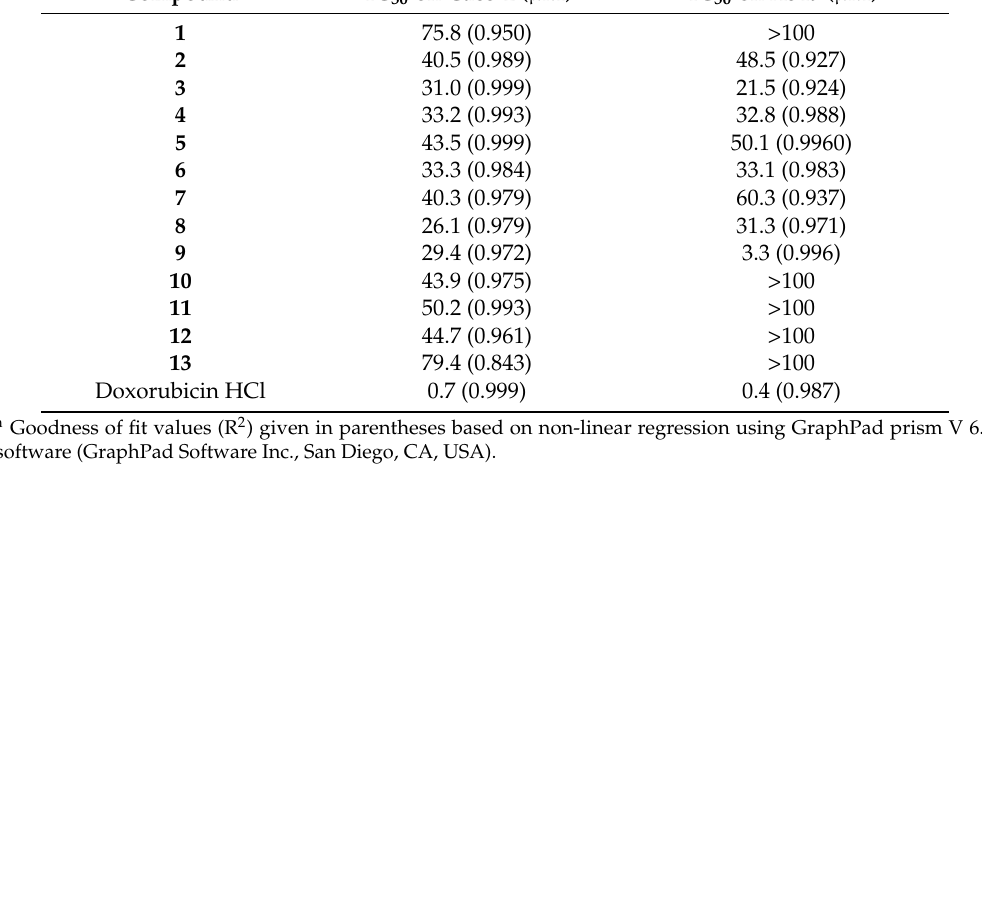
Table 2. IC 50 values for 1 – 13 against proliferation of human Caco-2 and A549 tumor cell lines.